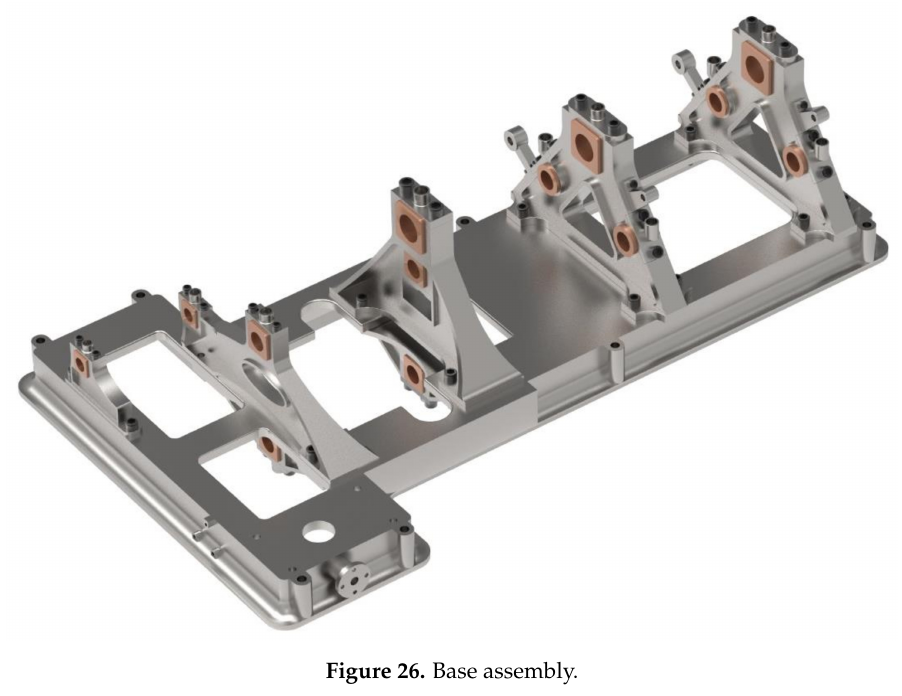
Figure 26. Base assembly.